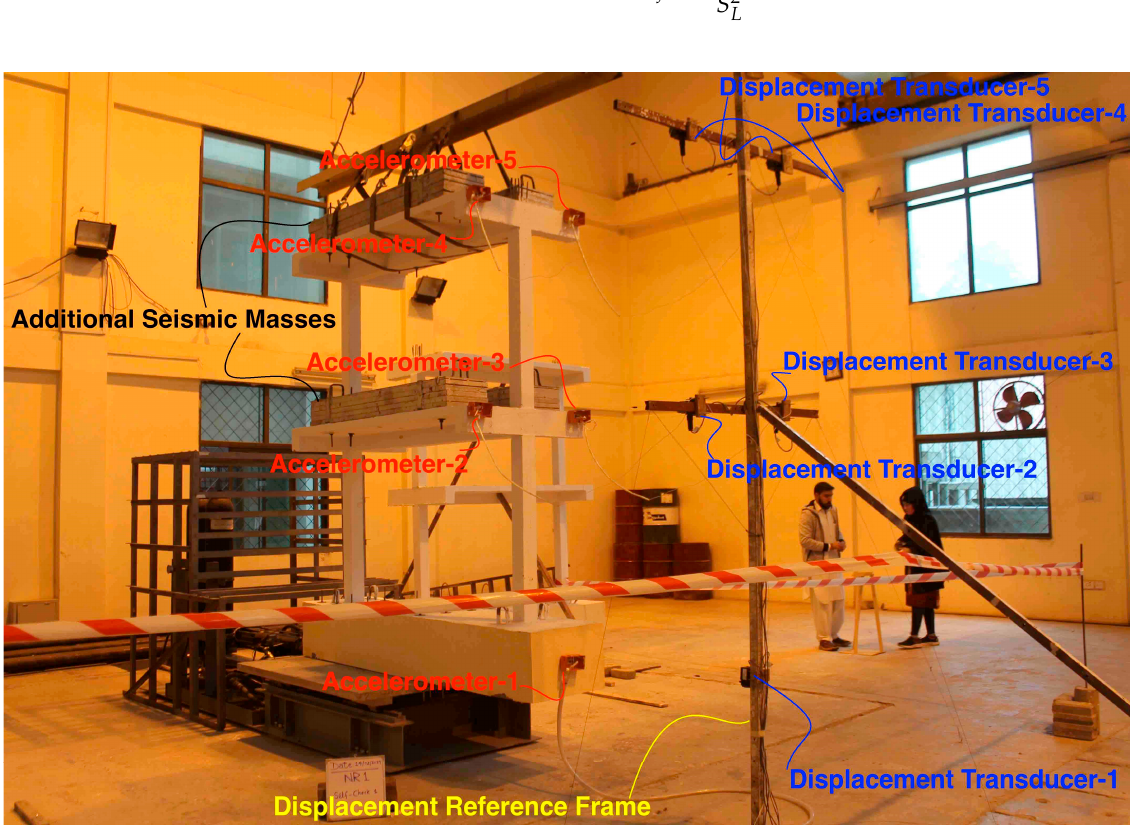
Figure 7. A 1:3 reduced scale test frame.